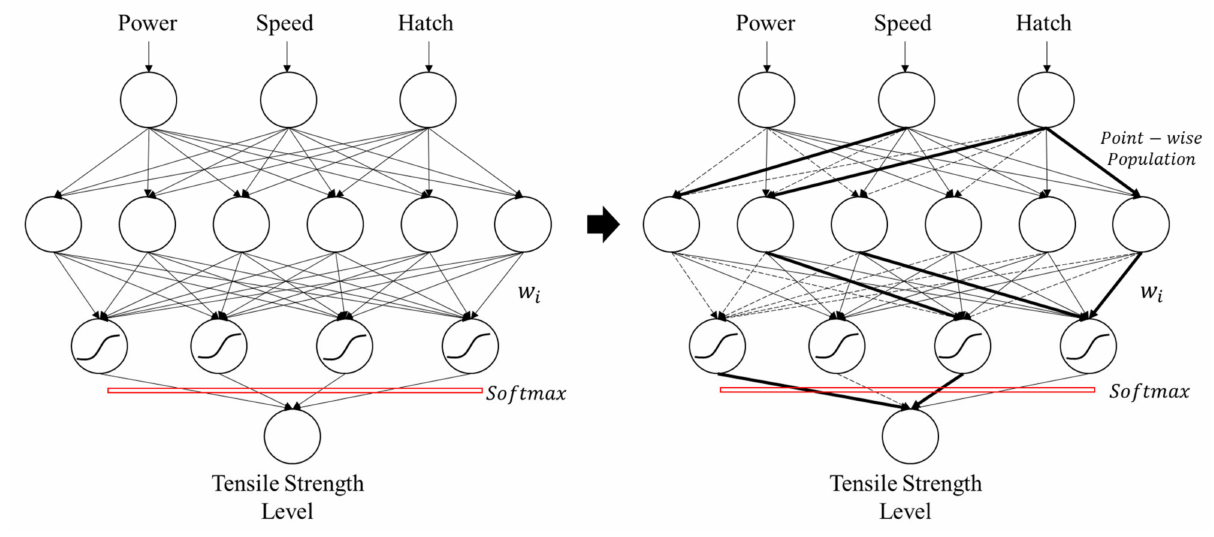
Figure 4. Self-growing Dynamic Neural